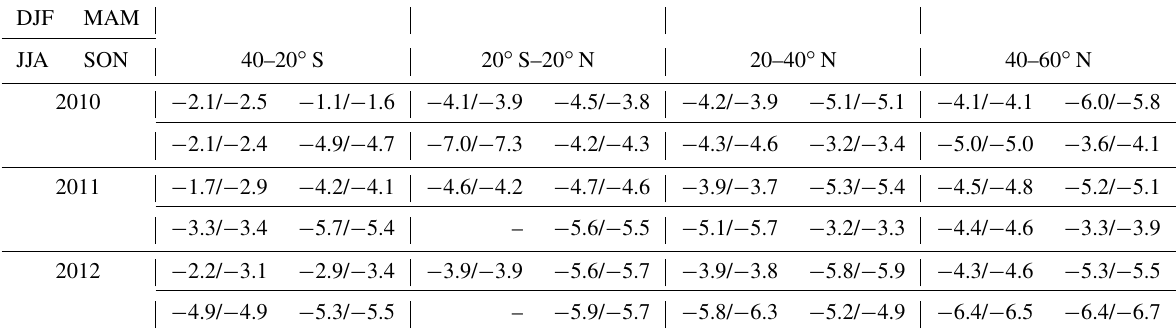
Table 2. Biases of GOSAT/TANSO-FTS TIR CO 2 data against CME_AK CO 2 data in each season of 2010–2012 at 541–464hPa (left side of each box) and at 464–398hPa (right side of each box) where the largest biases occurred in most cases; 541–464 and 464–398hPa correspond to retrieval layers 5 and 6, respectively. Biases could not be evaluated due to a lack of coincident data in the JJA seasons of 2011 and 2012.